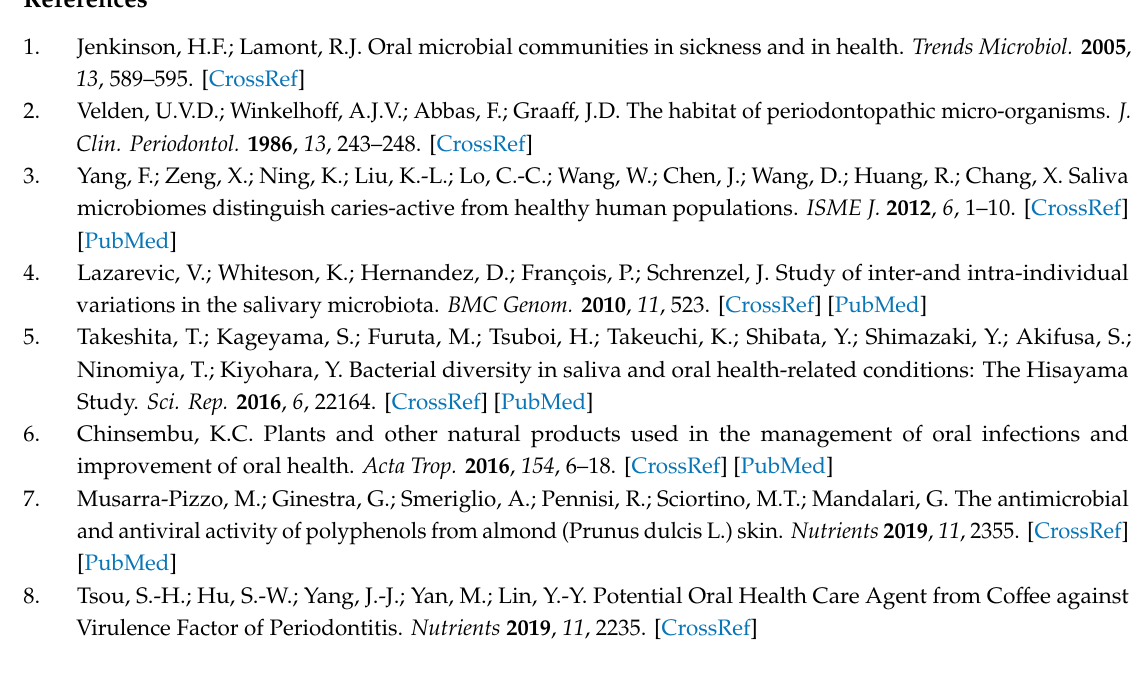
Figure S1: Chromatograms obtained from oolong tea infusion, using UHPLC Q-TOF-MS / MS in negative and positive ion modes, Figure S2: PCA score plot based on the relative abundance of all OTUs of the three subjects, Table S1: Summary of the sequencing results of all salivary